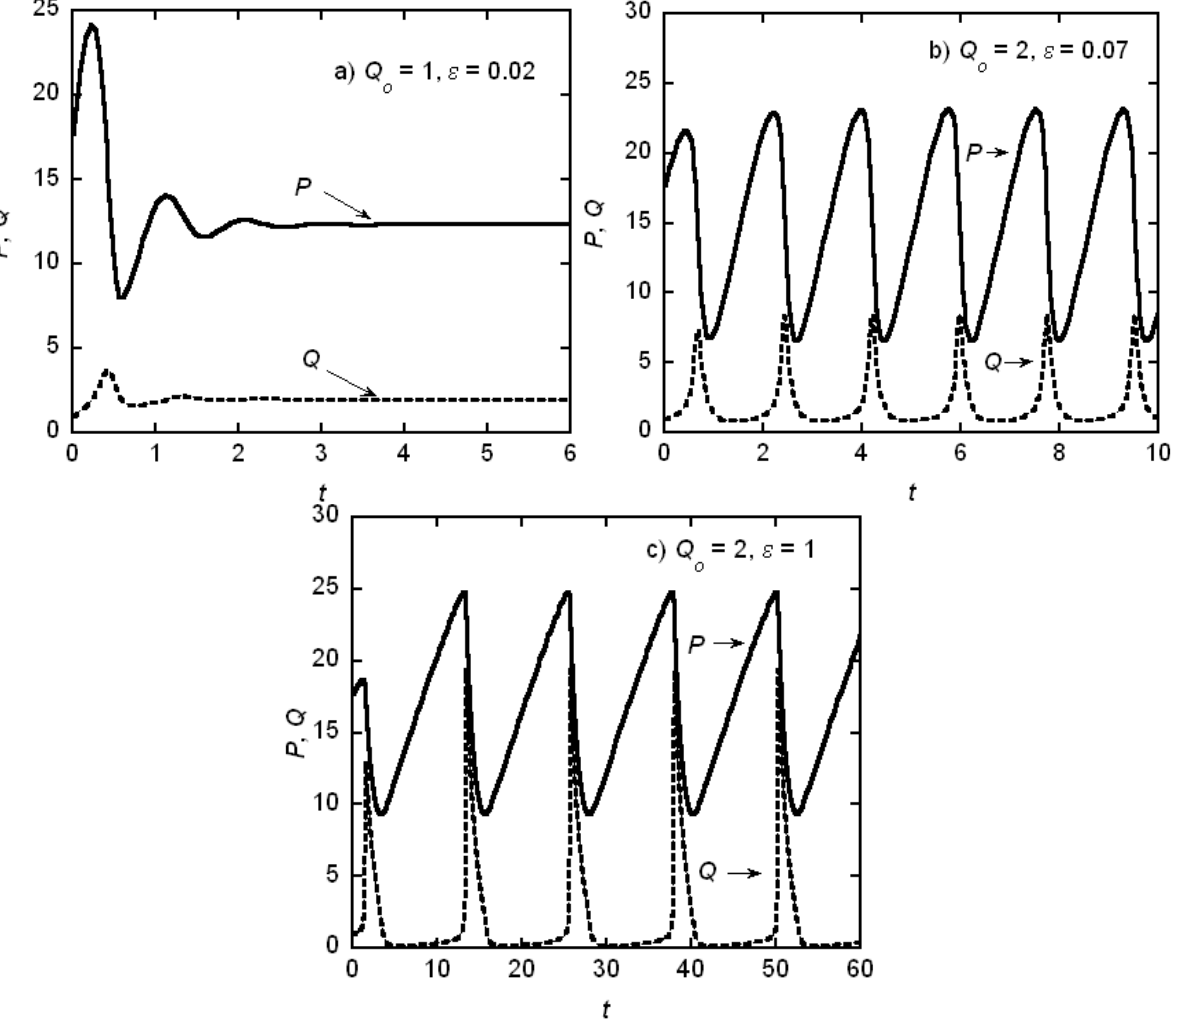
Fig. 4. Time series P(t) , Q(t) for the MBG model with β =5.5. (a) Q o =2, ε =0.02; (b) Q o =2, ε =0.07; (c) Q o =2, ε =1.0. Parameters values as in Table 1. The initial condition has been chosen as Q (0)=1 with an initial pressure and concentration profiles that have the steady state form for this value of Q